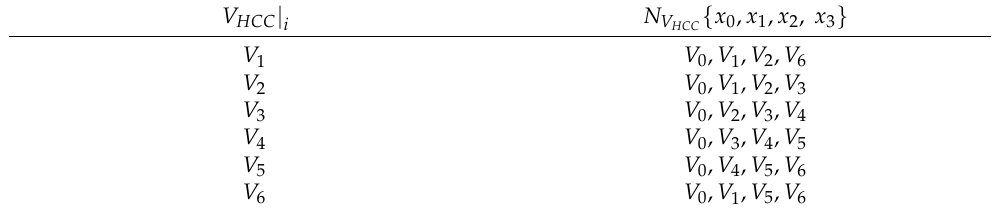
Table 1. VV selection used in HCC–MPCC.